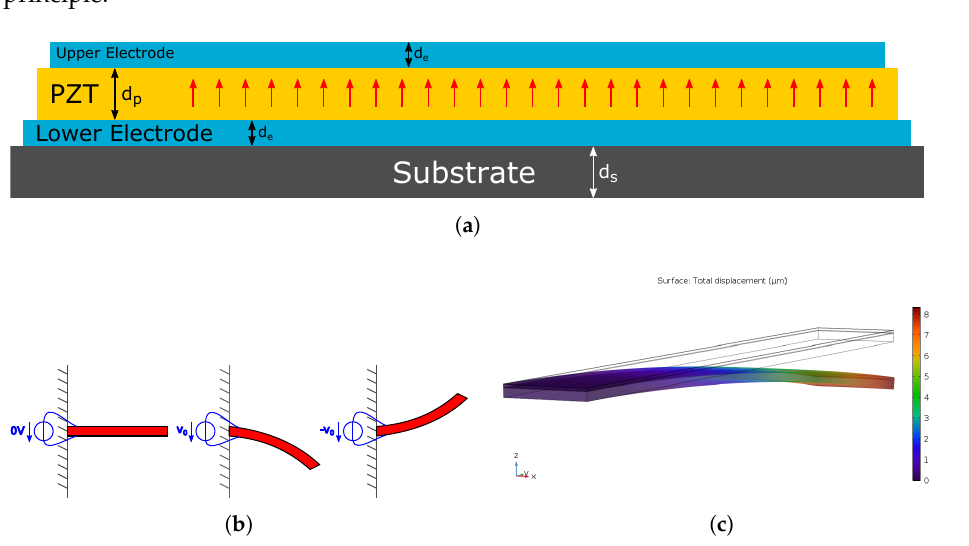
Figure 1. ( a ) Layered structure of the piezoelectric cantilever actuator with indicated polarisation direction (red arrows), ( b ) resting position and cantilever flexural modes, and ( c ) COMSOL simulation of the displaced cantilever (displacement